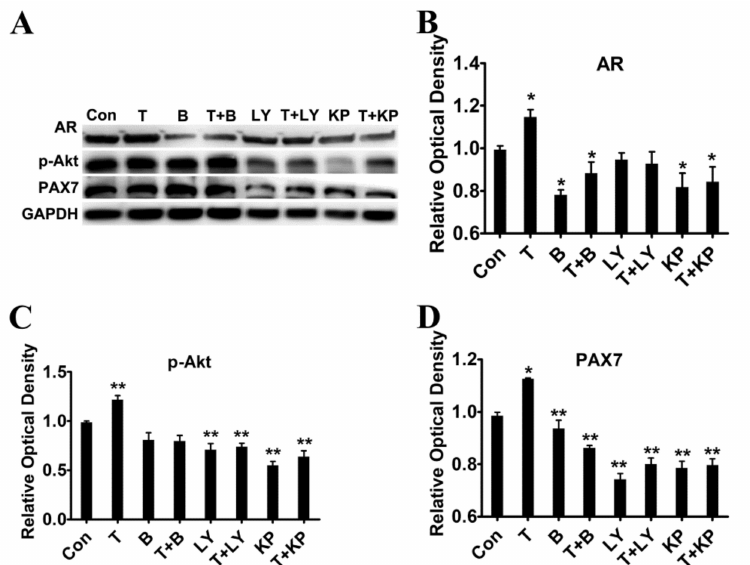
Figure 7. E ff ect of T and inhibitors on protein expression of AR and PAX7. ( A–D ): Protein expression level of AR, p-Akt and PAX7 after T and / or inhibitors treatment. Asterisk (*) represents statistically di ff erent ( p < 0.05), ** indicates that the di ff erence is extremely significant ( p <